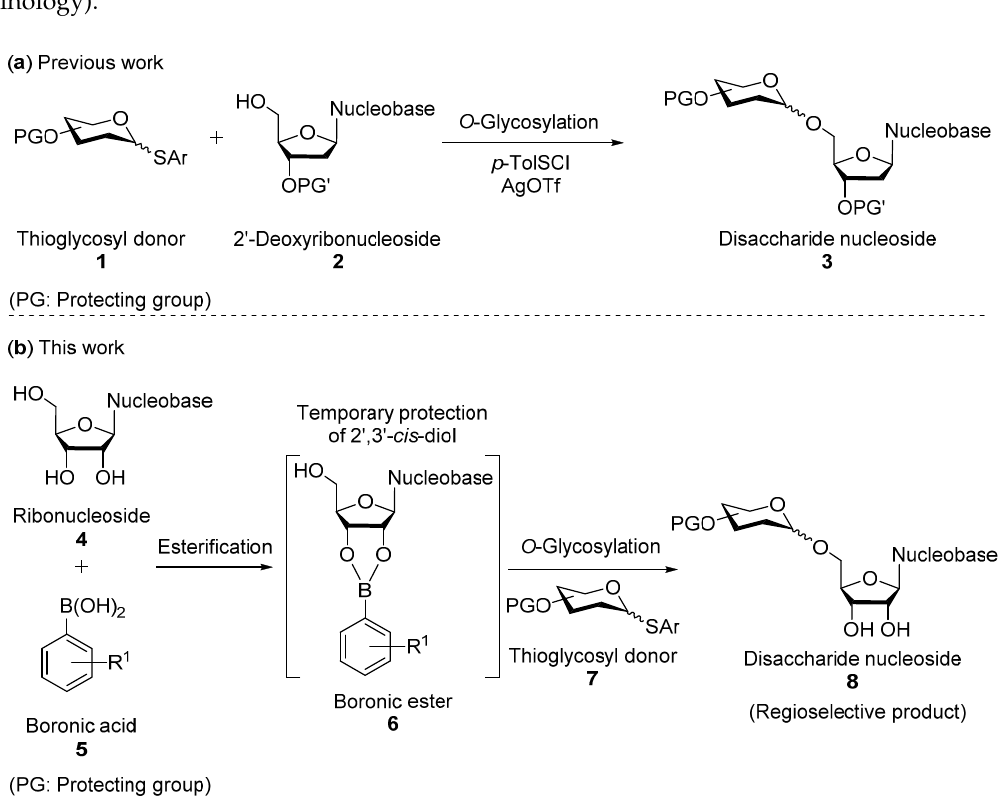
Figure 1. ( a ) O -glycosylation of 2 ′ -deoxyribonucleoside with a thioglycosyl donor using the p -toluenesulfenyl chloride ( p -TolSCl)/silver triflate (AgOTf) promoter system; ( b ) regioselective O -glycosylation of ribonucleoside at the 5 ′ -OH position via temporary protection of 2 ′ ,3 ′ - cis